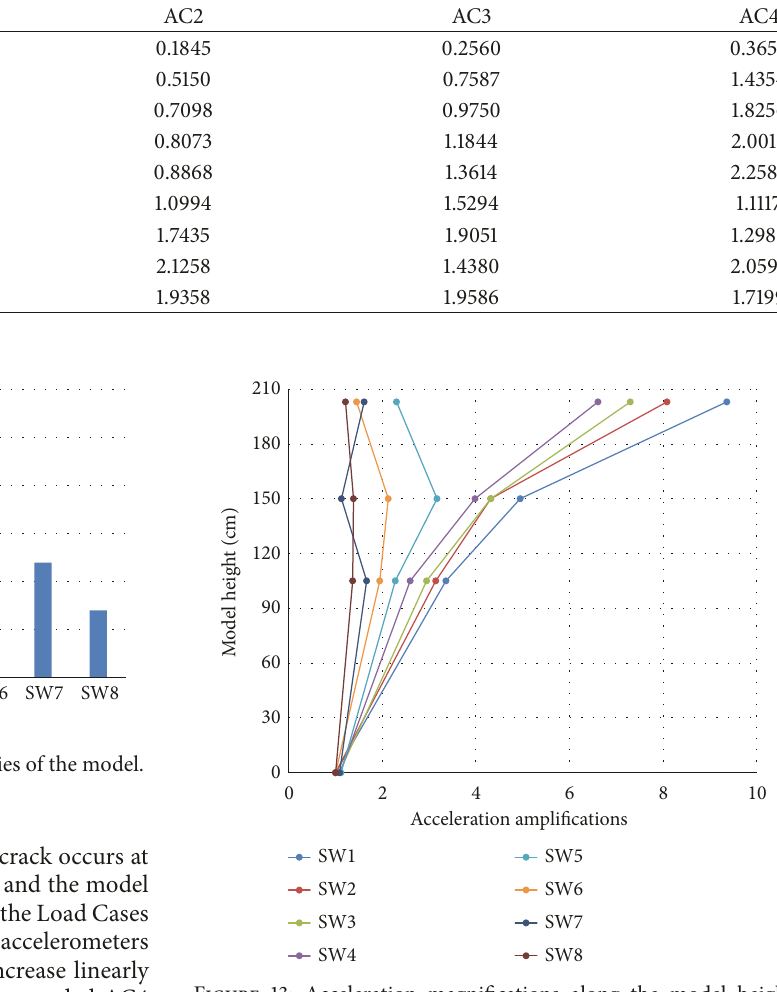
Figure 13: Acceleration magnifications along the model height under each load